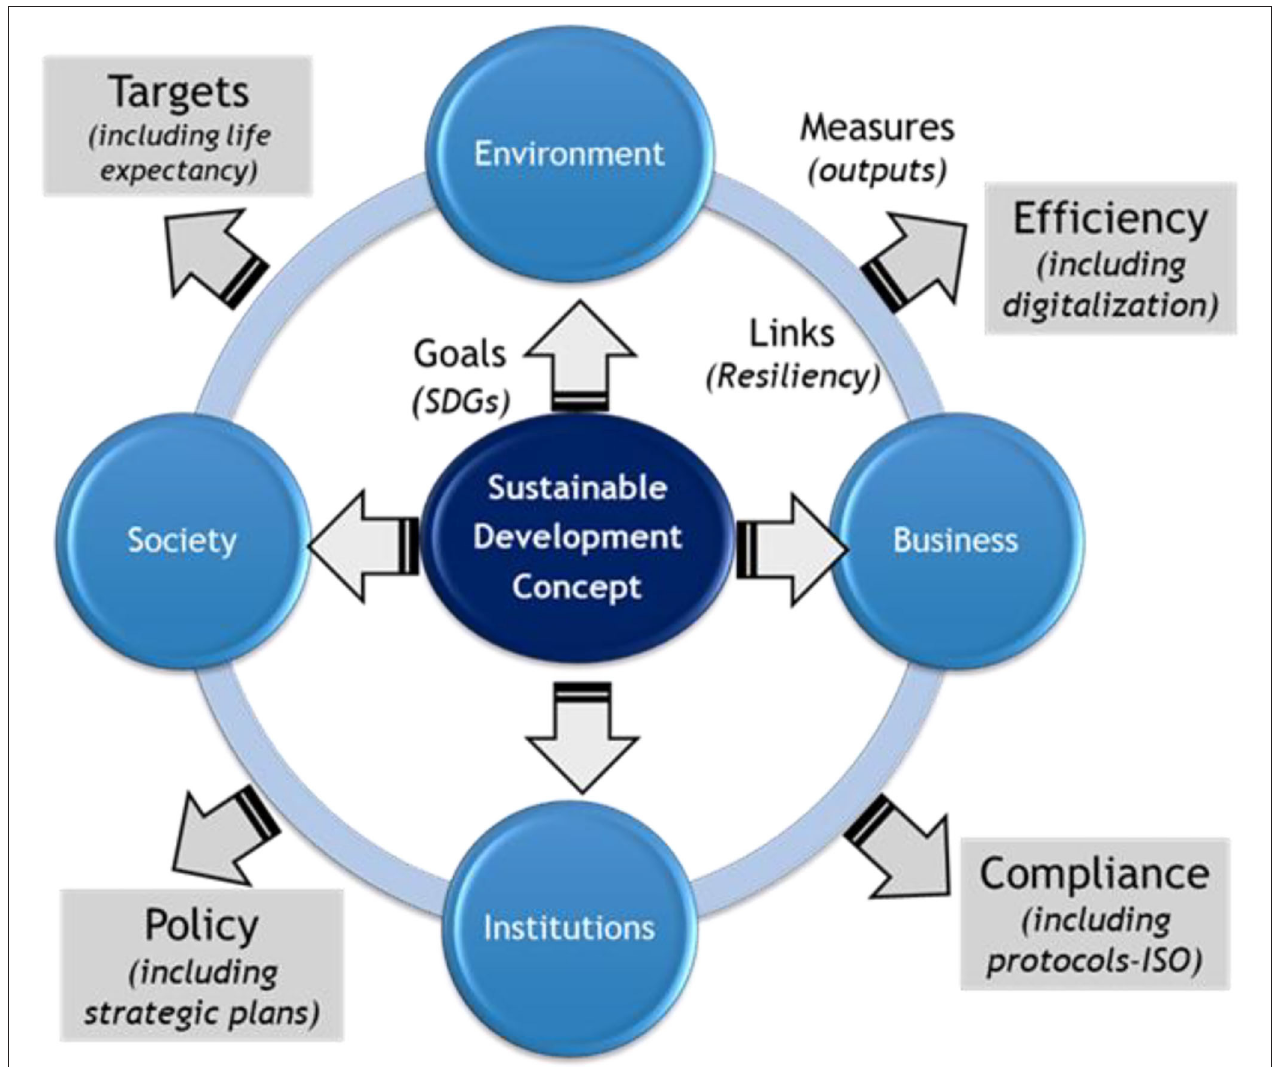
FIGURE 2 | Depiction of resilient and sustainable business performance (Dimitriou and Karagkouni,